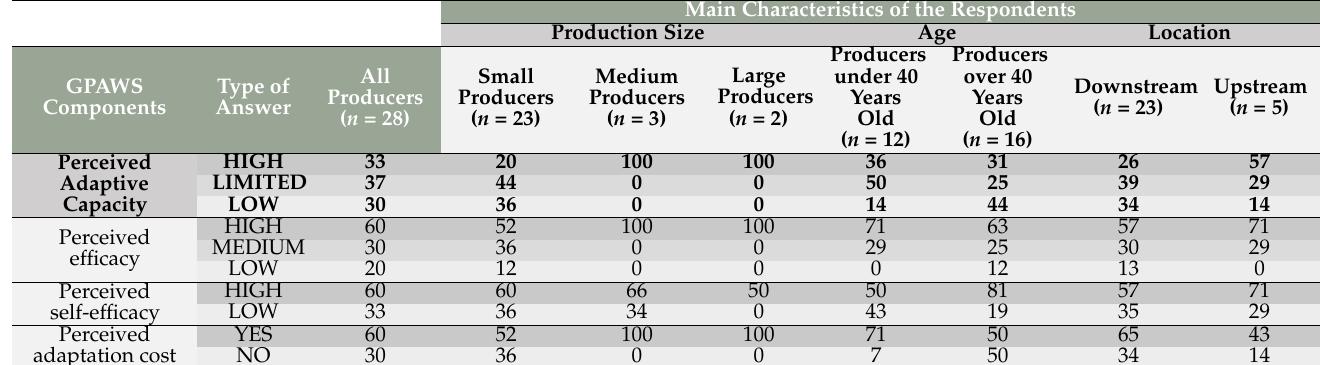
Table 3. Perceived Adaptive Capacity in relation to smallholders’ characteristics. Results represent the proportion (%) of the